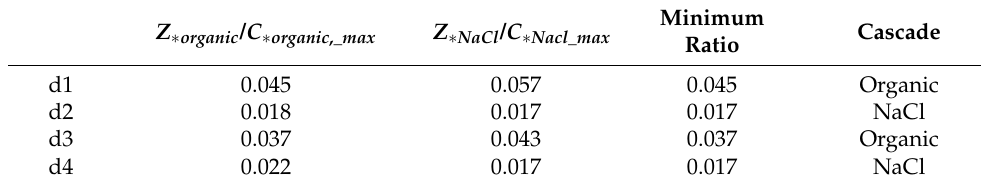
Table 2. Source prioritization sequence/contaminant cascade of each